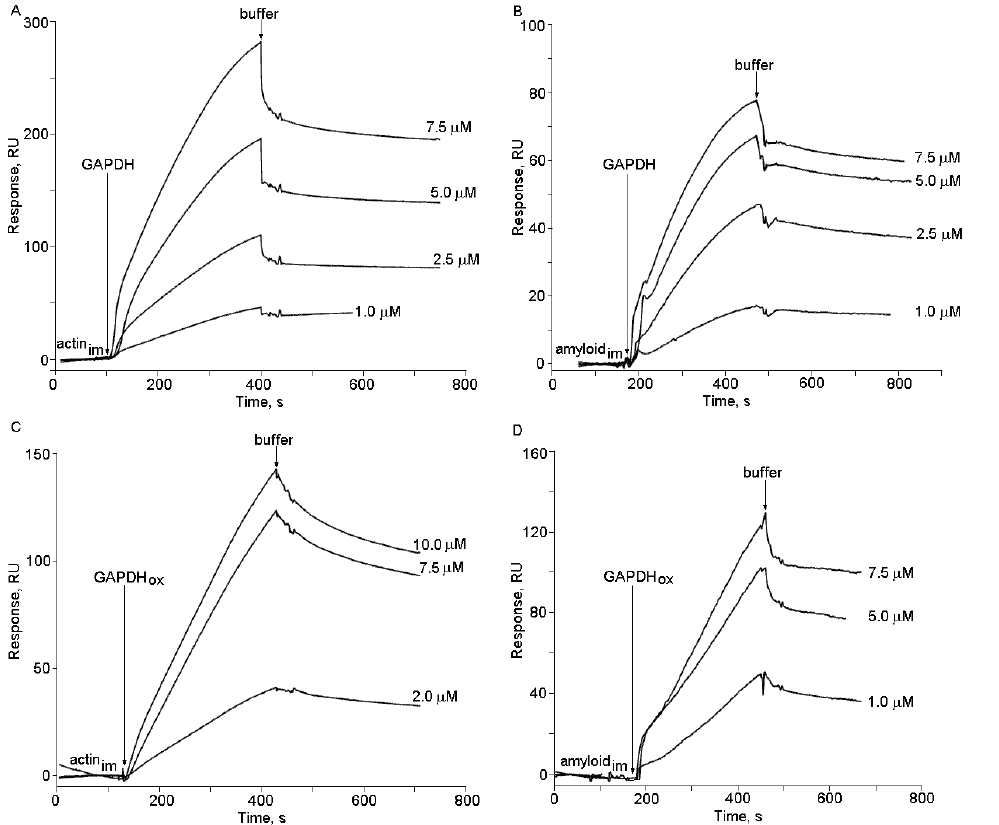
Figure 2. Sensograms of binding of native ( A , B ) and oxidized ( C , D ) glyceraldehyde-3- phosphate dehydrogenase (GAPDH) to immobilized actin ( A , C ) and amyloid- β ( B , D ). Arrows indicate onset of injection.